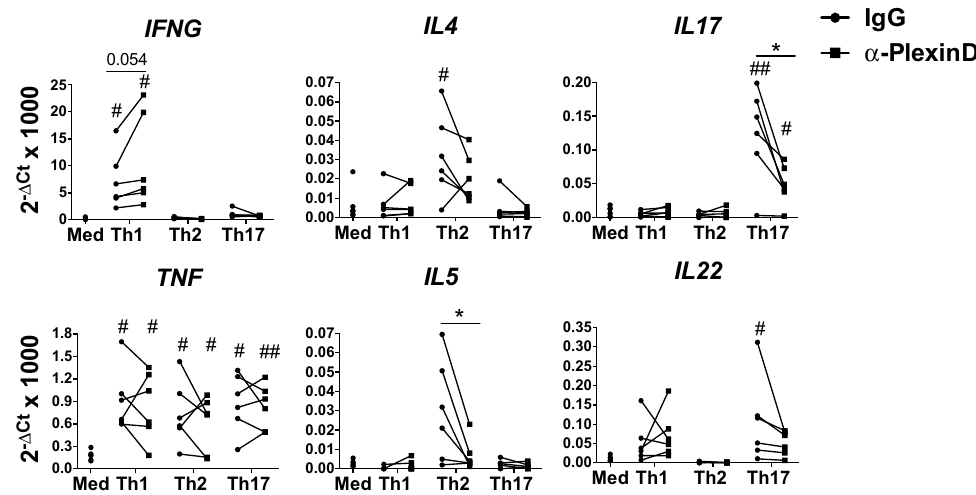
Figure 2. Sema4A-PlexinD1 axis inhibits Th1 and promotes Th2 and Th17 differentiation. Cytokines mRNA expression in naïve CD4 + T cells differentiated either in medium (Med), Th1, Th2 or Th17 differentiation cocktails in the presence of an anti-PlexinD1 antibody or its respective isotype control for 7 days ( n = 6). Data is presented as connected dots. * p < 0.05. # p < 0.05 and ## p < 0.01 compared to the medium.